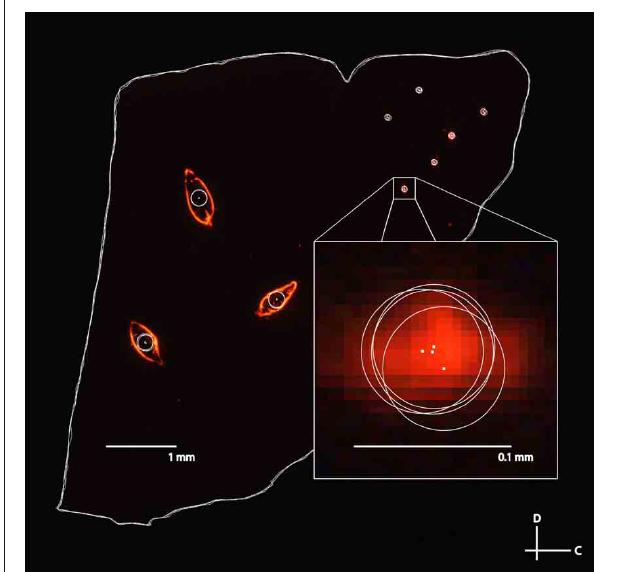
FIGURE 9 | Histogram of the distance of electrode shank points from their best fit line. Twelve total electrode shanks were randomly chosen from three brains. For each electrode shank, a perpendicular line was drawn between the electrode shank location (i.e., point) in each slice and the best fit line across slices. The distance of this perpendicular line was measured across slices, shanks and animals, and the values are displayed in the histogram, which presents the accuracy of alignment across slices. N = 290 electrode shank points.